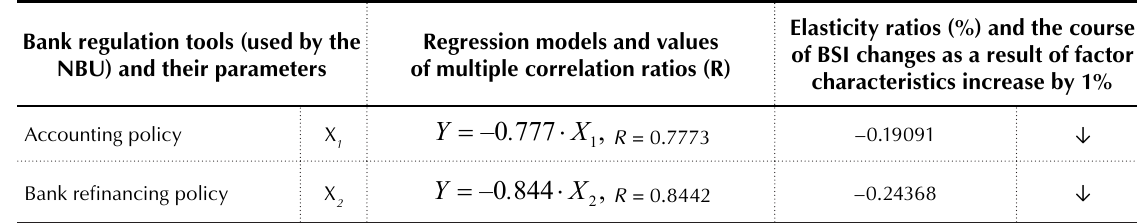
Table 4. Substantiating the most effective bank regulation tools based on the influence on the level of Ukrainian banking system stability Elasticity ratios (%) and the course Bank regulation tools (used by the Regression models and values of BSI changes as a result of factor NBU) and their parameters of multiple correlation ratios (R) characteristics increase by 1%